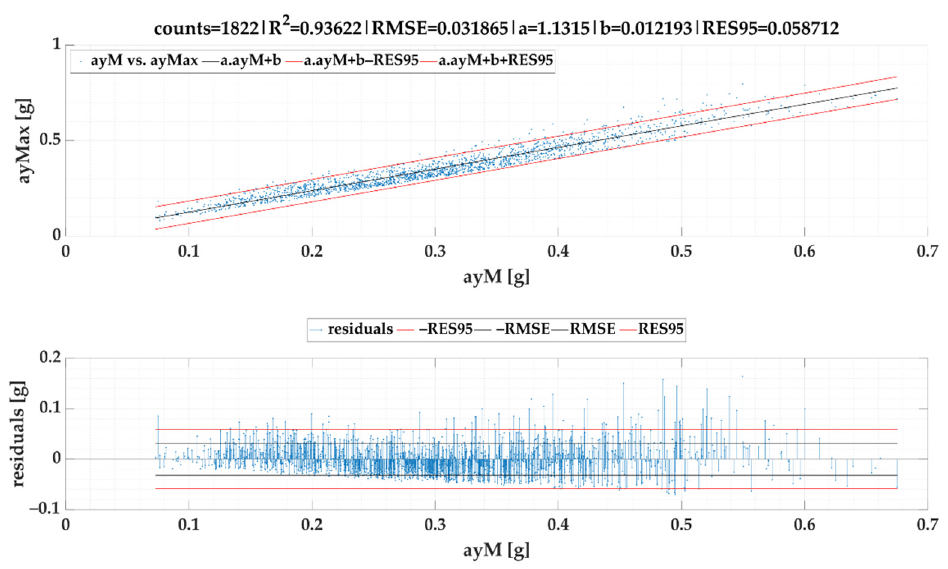
Figure 14. Maximum lateral acceleration ayMax vs. average lateral acceleration ayM of events for